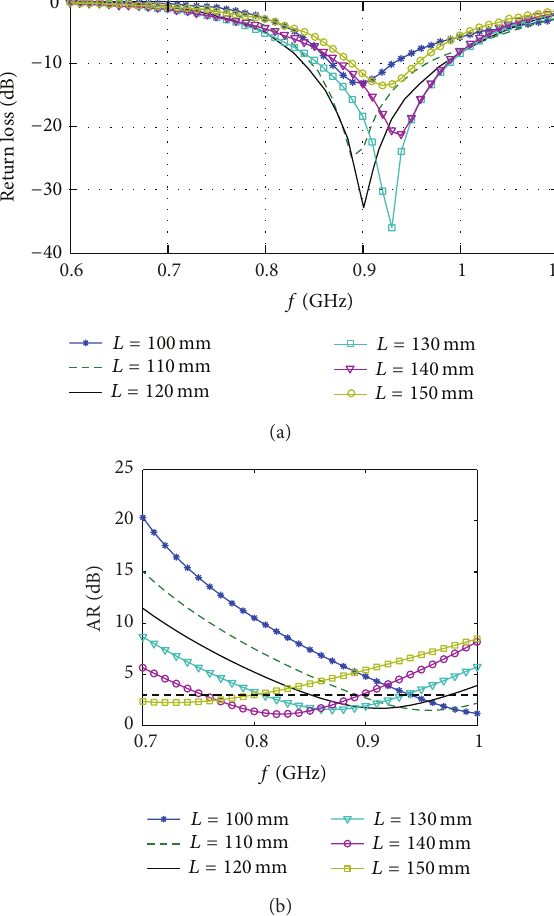
Figure 10: Comparison of S11 and AR of the antenna with different 𝐿 . (a) S11. (b) Axial